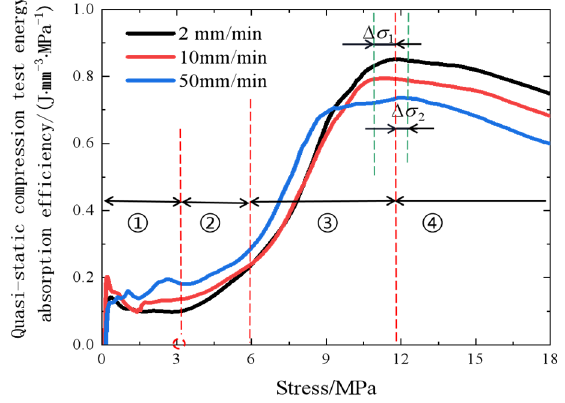
Figure 9. Energy absorption efficiency curve of open-cell aluminum foam.